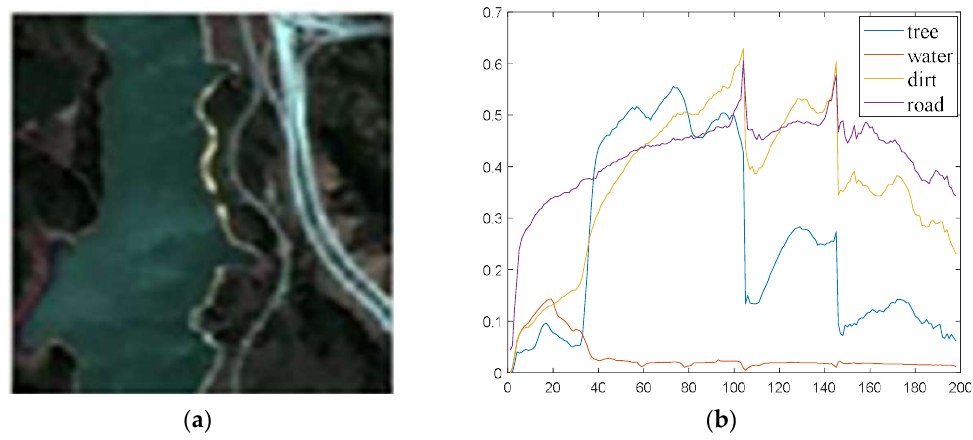
Figure 11. ( a ) The true color image of Jasper Ridge dataset; ( b ) ground truth of each feature. Table 3. Experimental results of Jasper Ridge